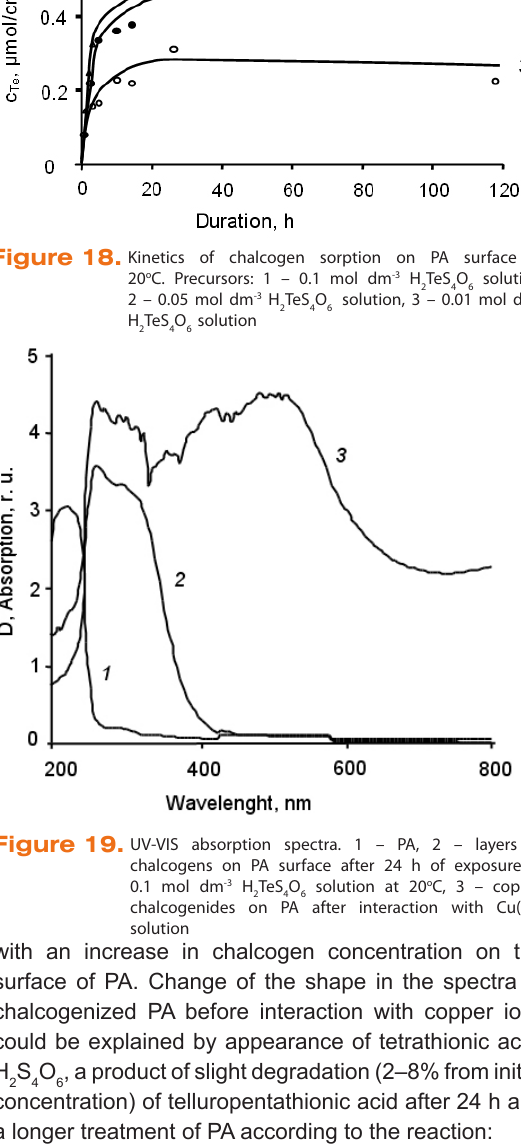
20 o C. Precursors: 1 – 0.1 mol dm -3 H